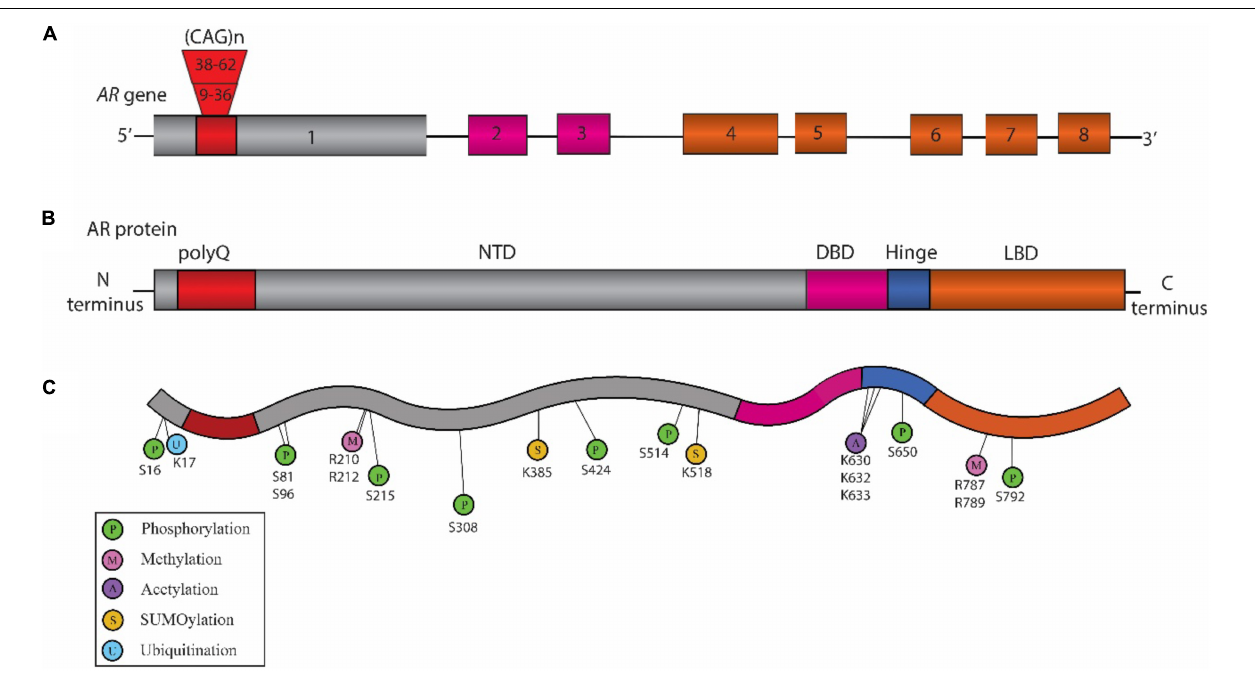
FIGURE 1 | Schematic representation of the structure of Androgen Receptor ( AR ) gene, protein, and posttranslational modifications (PTM) sites associated with Spinal and Bulbar Muscular Atrophy (SBMA) pathogenesis. (A) Structure of AR gene: The AR gene is located on the X chromosome and is comprised of eight exons. The color-coded exons indicate the major functional domains in the translated AR protein. (B) Domain architecture of AR: Schematic illustration showing the key domains that include the N-terminal domain (NTD, shown in gray), the DNA binding domain (DBD, pink), a short hinge region (blue), and the C-terminal ligand binding domain (LBD, orange) in the AR protein. (C) SBMA-associated PTM sites on the AR: The sites include phosphorylation sites (P, green), methylation sites (M, pink), acetylation sites (A, purple) SUMOylation sites (S, yellow), and ubiquitination sites (U, blue). The position of these PTM sites is indicated below their respective